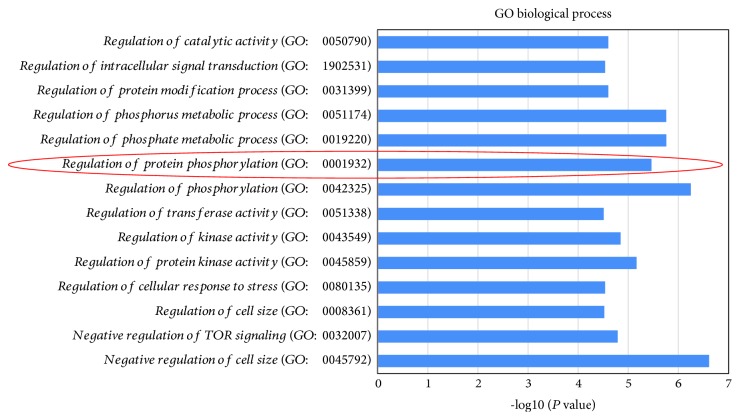
Enrichment of the DEPs in biological processes. The regulation of protein phosphorylation (GO: 0001932) was significantly enriched, indicating its involvement in the development and progression of PC (P < 0.05).